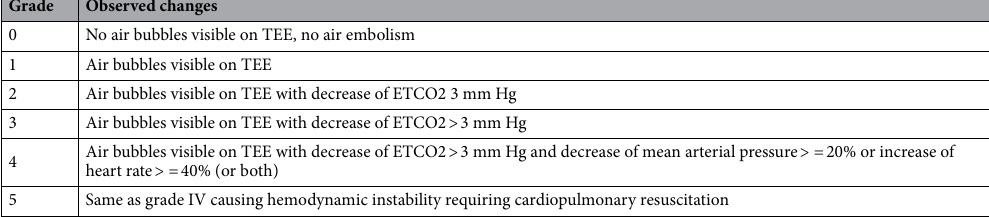
Table 1. Tübingen Venous Air Embolism Grading Scale. TEE transesophageal echocardiography; ETCO2 end- tidal carbon